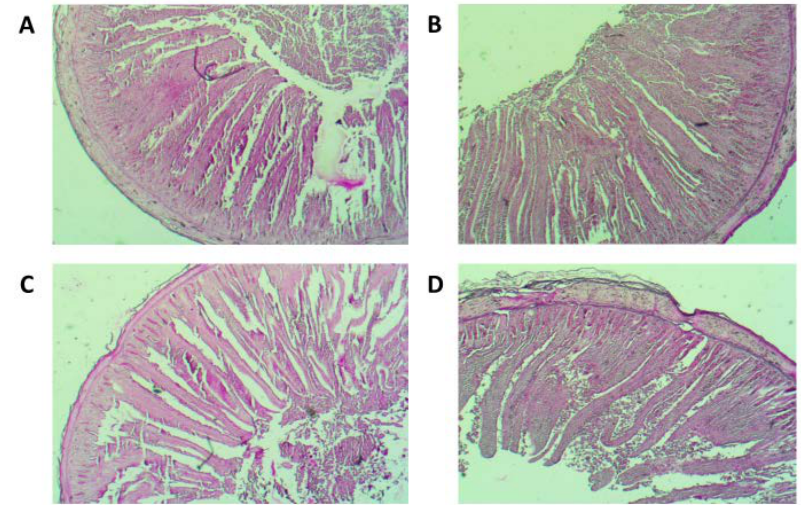
Figure 2. Effect of the in ovo RFO prebiotic treatment on the histomorphology of duodenum in broiler chicken. ( A ) Photomicrograph (light microscope) of the duodenum in the RFO group on day 21. Periodic acid-Schiff (PAS) reaction, magn. ×32; ( B ) photomicrograph (light microscope) of the duodenum in the RFO group on day 42. PAS reaction, magn. ×32; ( C ) photomicrograph (light microscope) of the duodenum in the Control group on day 21. PAS reaction, magn. ×32; ( D ) photomicrograph (light microscope) of the duodenum in the Control group on day 42. PAS reaction, magn. ×32.